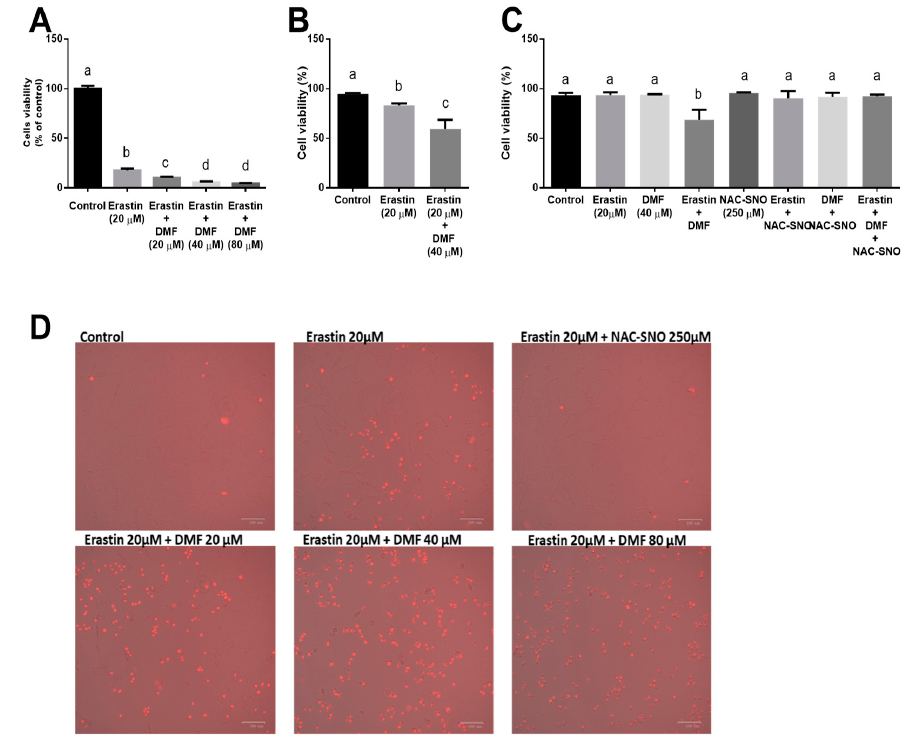
Figure 1. The effect of DMF on cell viability in ferroptosis . ( A ) Cell viability was evaluated by MTT assay in AML12 treated with 20 µ M erastin with or without 20, 40, and 80 µ M DMF for 24 h. ( B ) Cell death was measured by propidium iodide (PI) staining qualitatively by flow cytometry of AML12 cells treated with 20 µ M erastin with or without 40 µ M DMF and 250 µ M NAC-SNO for 24 h. (10,000 cells, n = 3) ( C ) Cell death measured by propidium iodide (PI) staining qualitatively by flow cytometry of AML12 treated with erastin with or without DMF (10,000 cells, n = 3). ( D ) Propidium iodide (PI) staining of AML12 treated with erastin, with DMF and NAC-SNO. Red-stained cells: dead/damaged cells; non-stained cells: normal cells. Means with different letters are statistically different ( p < 0.05).